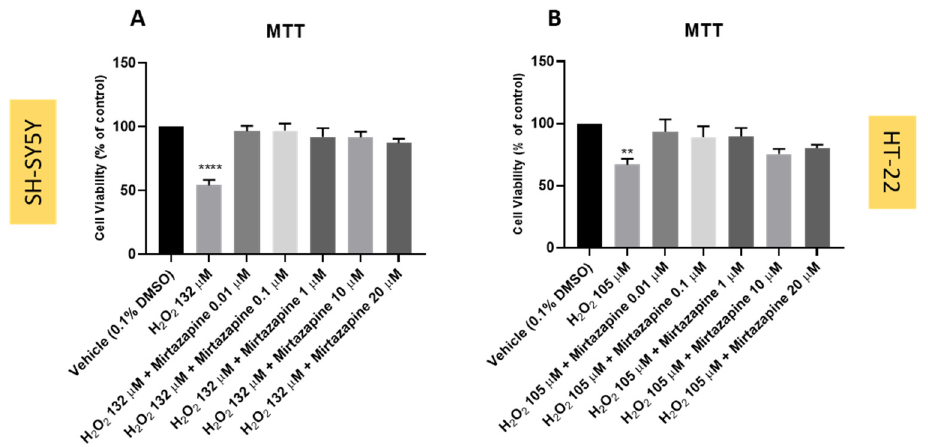
Figure 5. Effect of 48 h-incubation of ( A ) 132 µ M of H 2 O 2 and ( B ) 105 µ M of H 2 O 2, in combination with 0.01–20 µ M of mirtazapine, determined by MTT methodology. The results represent the mean ± SEM of 3–6 independent experiments, expressed as the percentage of the vehicle (100%). Statistically significant ** p < 0.01 and **** p < 0.0001 vs. vehicle.